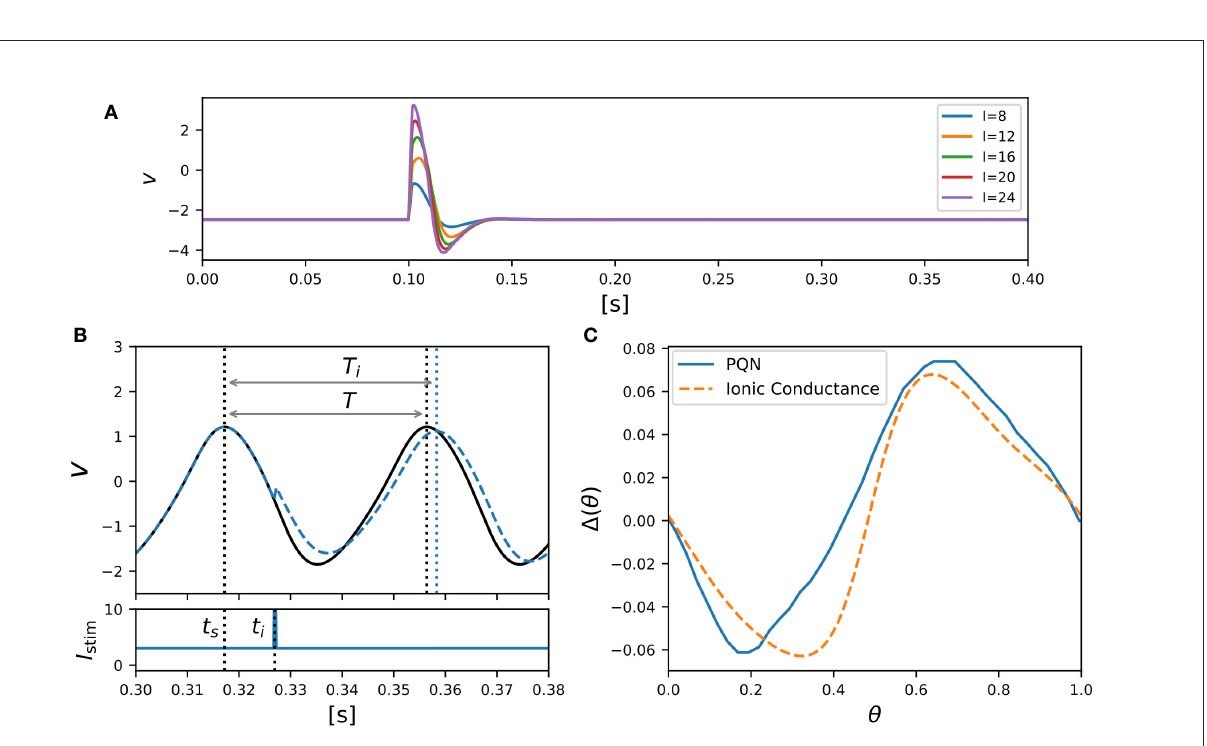
FIGURE5 PQN model of Class II mode in the Hodgkin’s classification. (A) Graded responses to pulse stimuli. Pulse stimuli of various magnitudes were given between 0.1 and 0.102 [s]. (B) Phase changes induced by the pulse stimulus. (C) PRCs of the PQN model and the ionic-conductance model. The horizontal axis represents the phase at which the pulse stimulus was given, and the vertical axis represents how much the phase was shifted by the pulse stimulus.